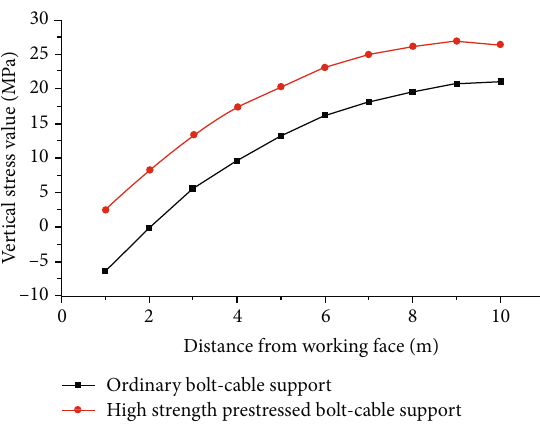
Figure 11: Vertical stress of the